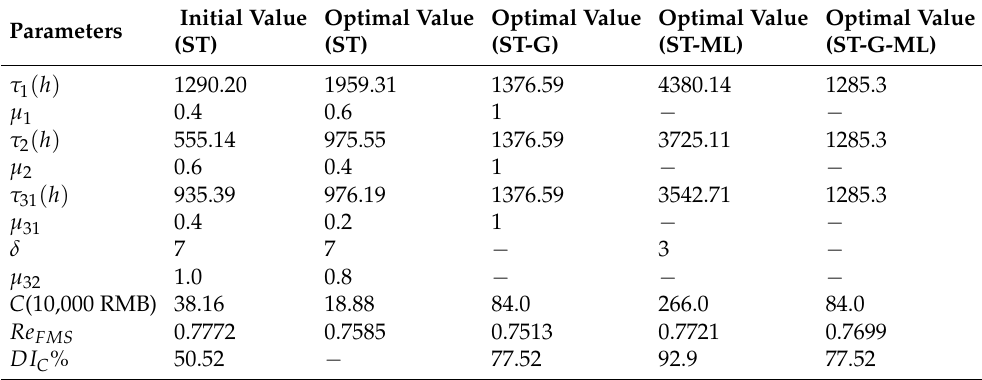
Table 5. Comparison of optimal